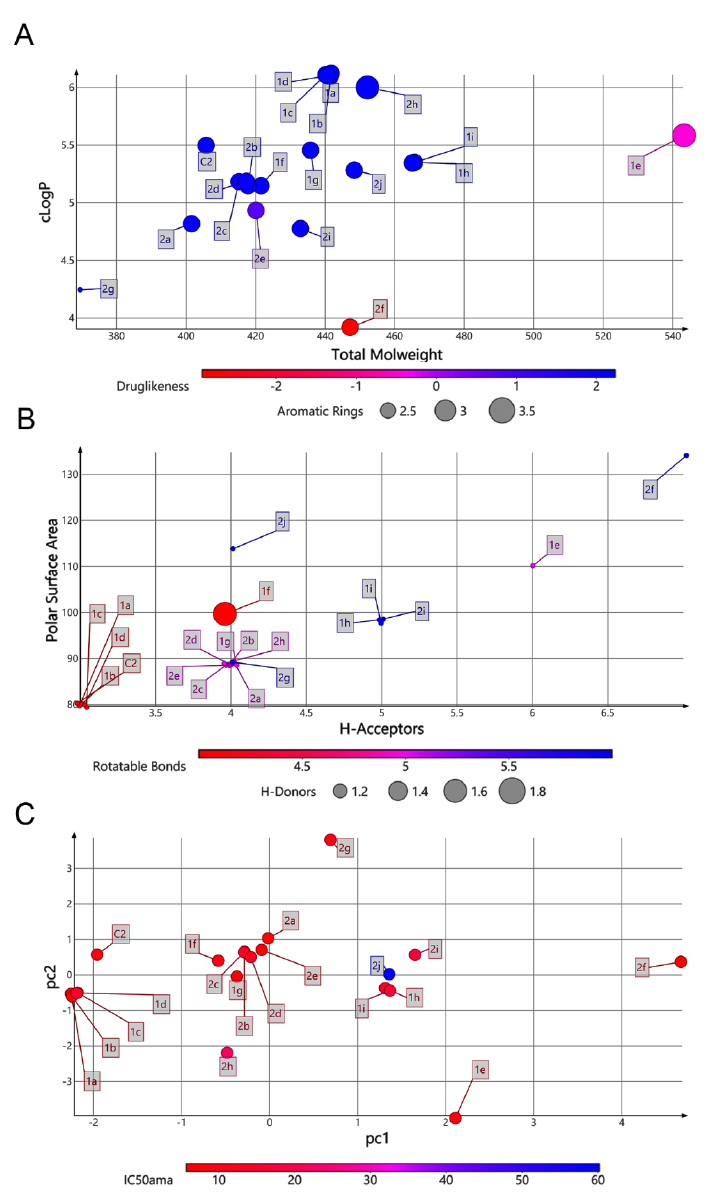
Figure 2. Physicochemical properties of 1,4-naphthoquinone series. Relationship of physicochemical properties between cLogP x Molecular Weight x Drug-likeness × number of aromatic rings ( A ); polar surface area x hydrogen bond acceptors x hydrogen bond donors x rotatable bonds ( B ) and ( C ) principal component analysis (PCA).